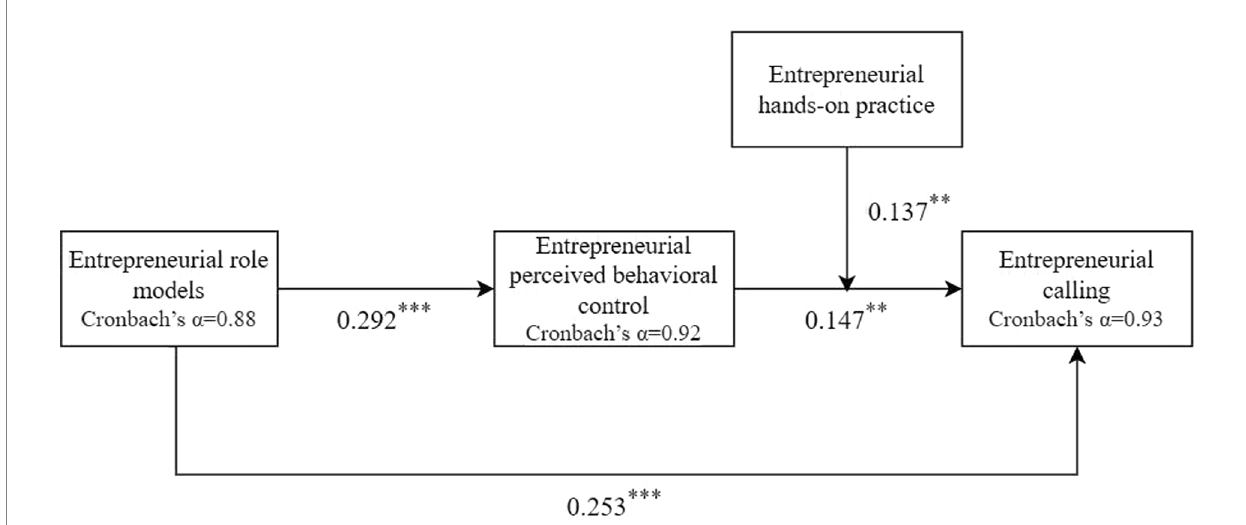
FIGURE 4 A moderated mediation model of the association between entrepreneurial role models and entrepreneurial calling through entrepreneurial perceived behavioral control, entrepreneurial hands-on practice. Cronbach’s Alpha values and path coefficients are shown. ** p < 0.01; *** p <